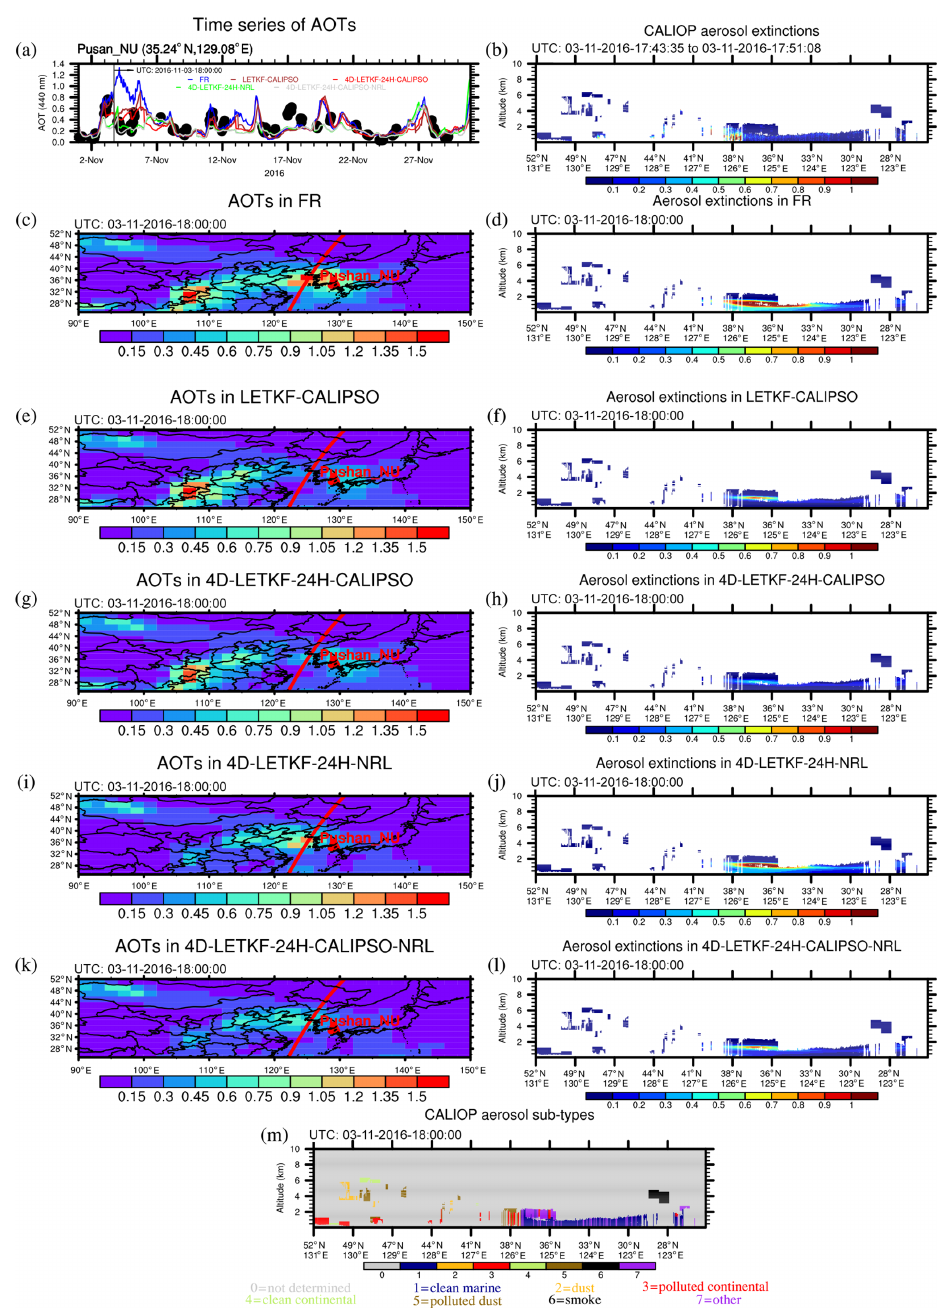
Figure 10. (a) Hourly time series of the AOTs at 440nm for the FR, LETKF-CALIPSO, 4D-LETKF-24H-CALIPSO, 4D-LETKF-24H- NRL, and 4D-LETKF-24H-CALIPSO-NRL experiments and the observed AOTs from the AErosol RObotic NETwork (AERONET) over the Pushan_NU site during November 2016. The root mean square error (RMSE) and correlation coefficient (CORR) between the simulated and observed AOTs are also shown. The spatial distributions of the simulated AOTs at 440nm at 18:00:00 (UTC) on 3 November 2016 in the FR (c) , LETKF-CALIPSO (e) , 4D-LETKF-24H-CALIPSO (g) , 4D-LETKF-24H-NRL (i) , and 4D-LETKF-24H-CALIPSO-NRL (k) experiments. The red triangle indicates the location of the Pushan_NU site. The red curve indicates one CALIPSO orbit path near the Pushan_NU site on 3 November 2016. The CALIOP-observed aerosol extinction coefficients at 532nm (km − 1 ) (b) and the simulated ones at 550nm in the FR (d) , LETKF-CALIPSO (f) , 4D-LETKF-24H-CALIPSO (h) , 4D-LETKF-24H-NRL (j) , and 4D-LETKF-24H-CALIPSO- NRL (l) experiments over that CALIPSO orbit path. (m) CALIPSO-derived vertical aerosol